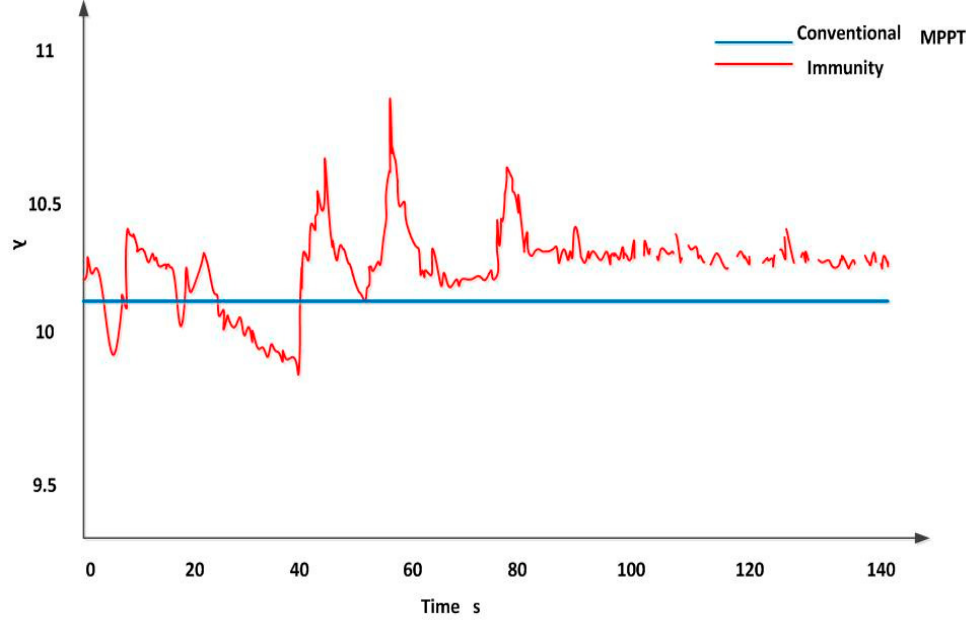
Figure 16. The comparison of TSR for both MPPT strategies.